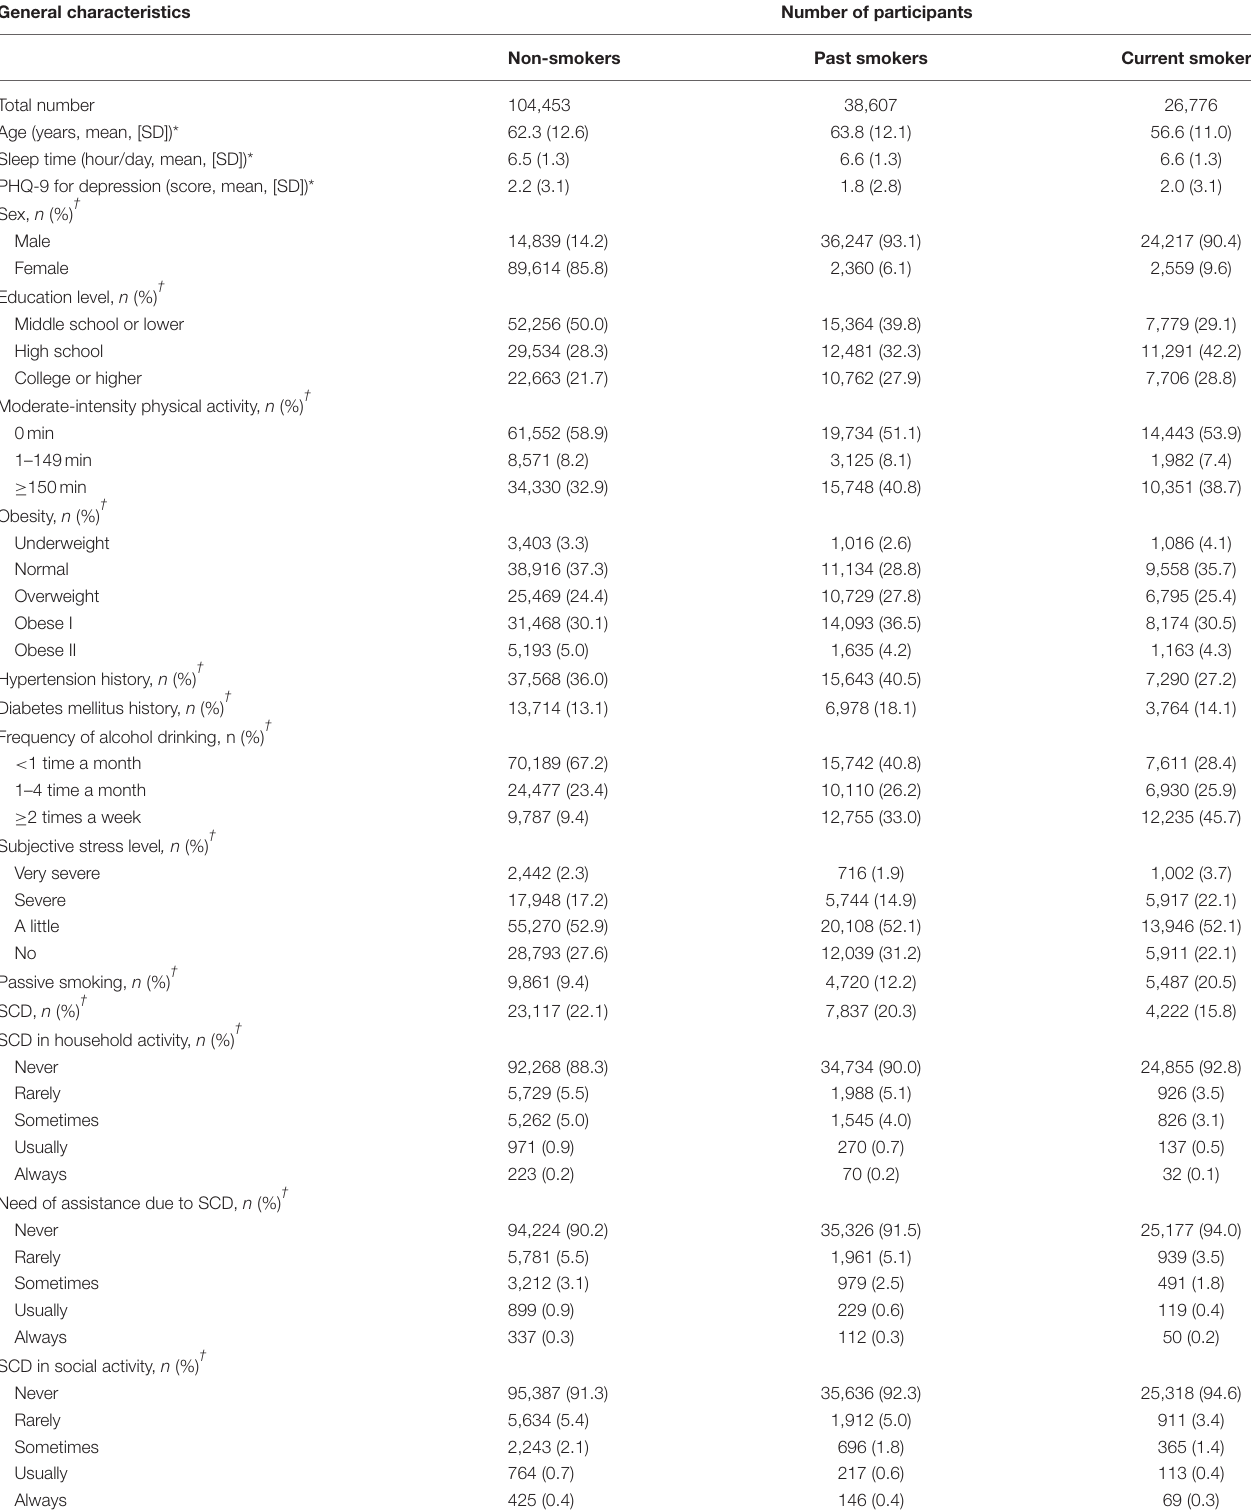
TABLE 1 | General characteristics of the participants according to current smoking